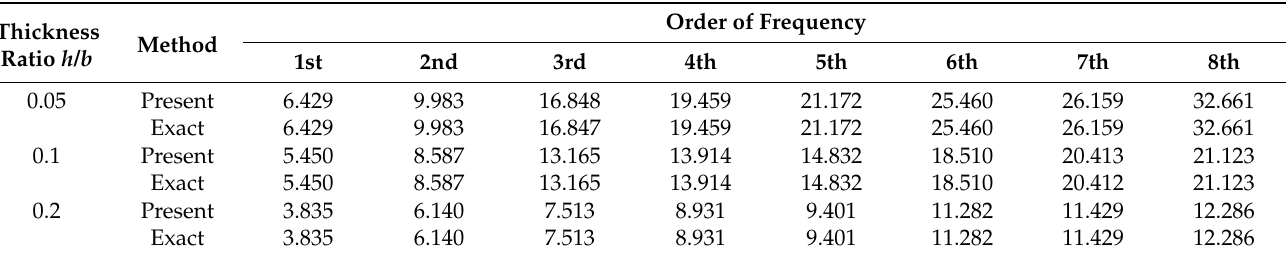
Table 9. The nondimensional frequency Ω for SSSC laminates.